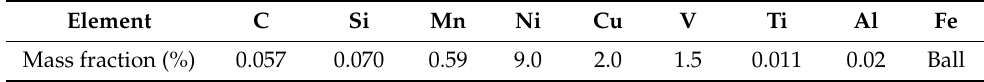
Table 1. Chemical analysis of experimental steel (mass fraction, %).